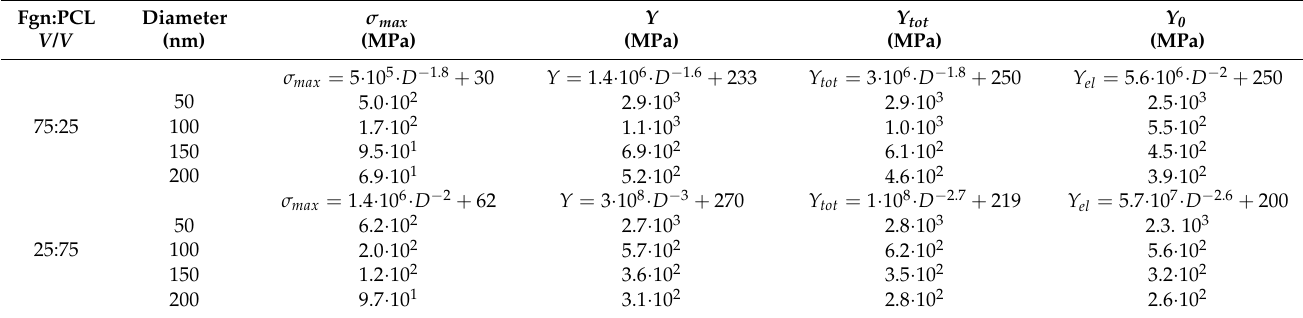
Table 2. Mechanical properties that exhibit diameter dependence, in addition to ratio dependence. Maximum stress, σ max , Young’s modulus (initial slope of stress–strain curve), Y , total modulus Y tot , and relaxed, elastic modulus, Y 0 , for electrospun fibrinogen:PCL nanofibers with 75:25 and 25:75